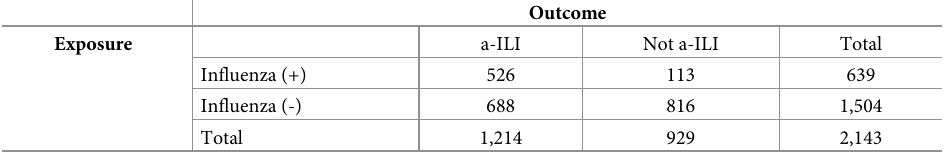
Table 5. Relationship between influenza laboratory detection and absence with influenza-like illness (a-ILI) in a cohort of students visited at